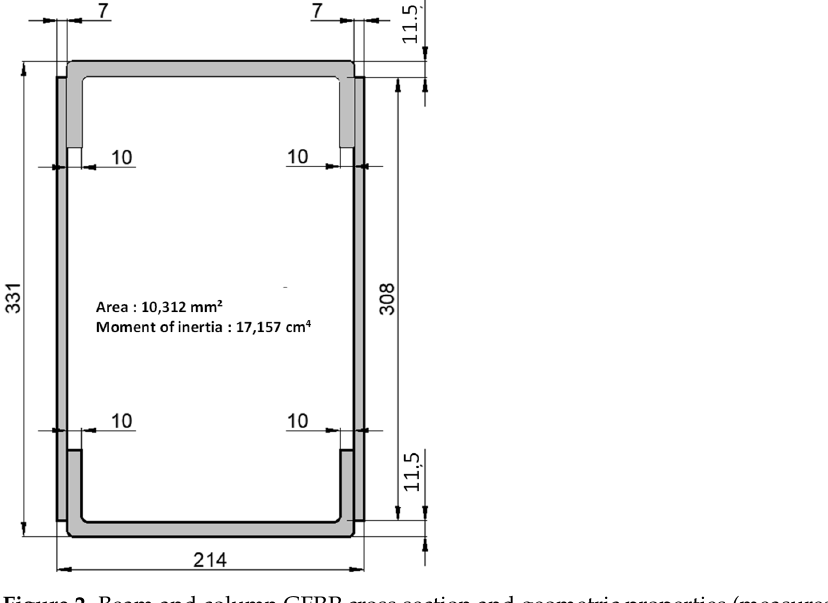
Figure 2. Beam and column GFRP cross section and geometric properties (measures in mm).